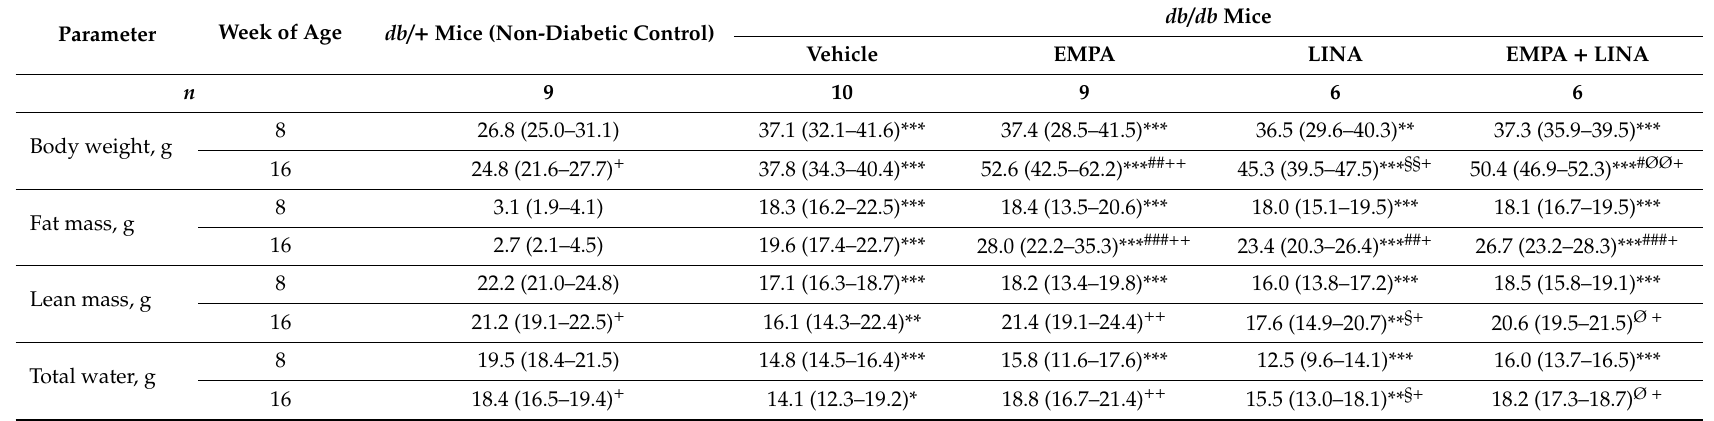
Table 1. Body weight and body composition in db /+ and db / db